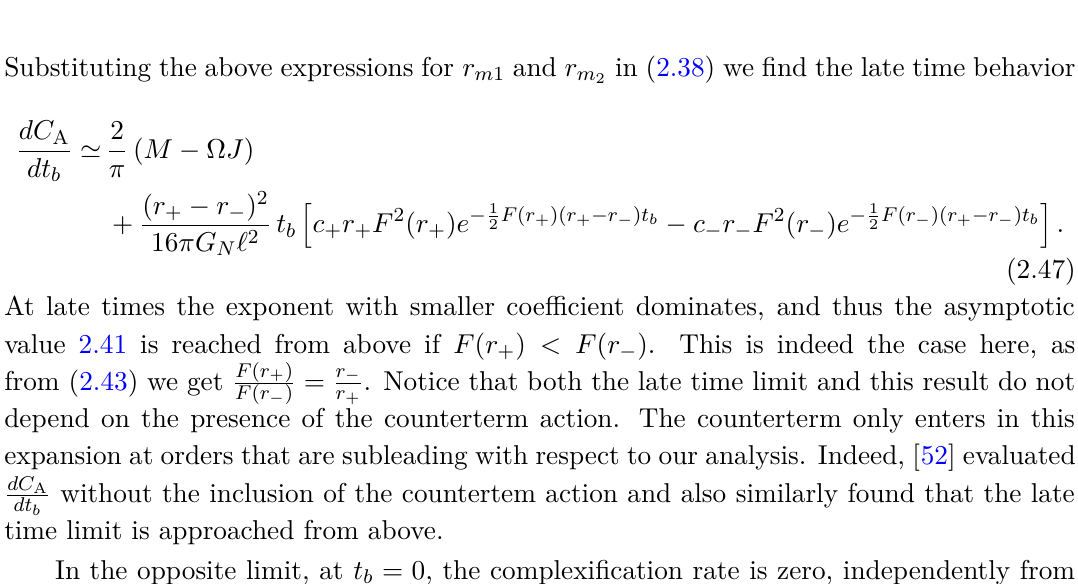
Figure 2 . π dC A with M = 2 , ‘ = G N = α = L ct = 1 and (left) J = 0 . 1 , (center) J = 1 , (right) dt b J = 1 . 999 . The CA rate with the counterterm is depicted in blue solid, in red dashed without. In black dotted the late time value